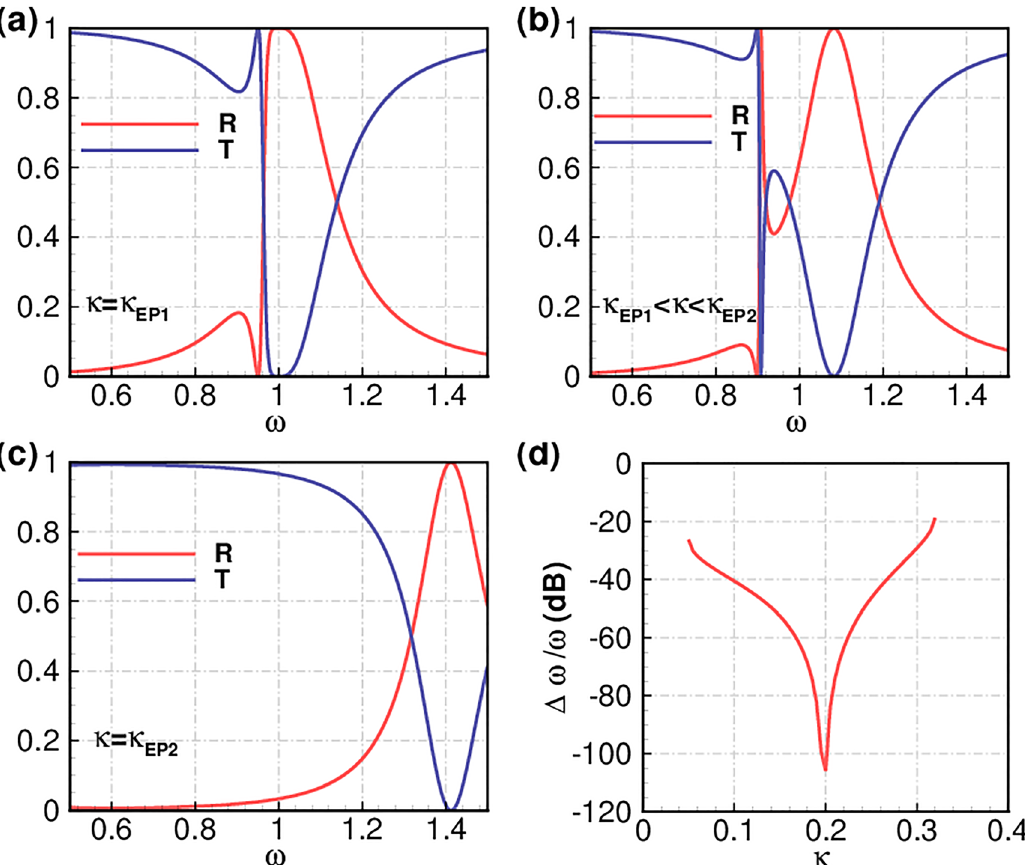
Figure 3: Drastic tailoring of the scattering spectrum with EP engineering in the PT-APT-symmetric system. R indicates re fl ectance and T